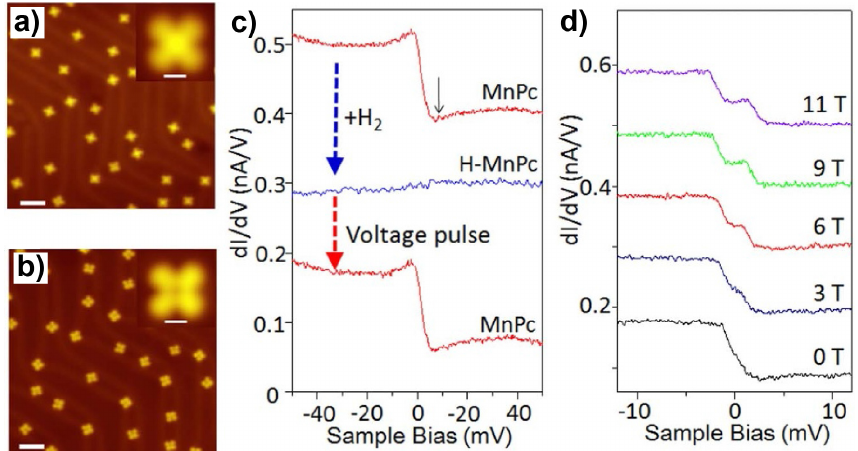
Figure 6. STM images of ( a ) MnPc and ( b ) H-MnPc on Au(111). ( c ) Sequential variations of d I / d V spectra recorded at the center of a MnPc molecule induced by the adsorption and desorption of a H atom. ( d ) Magnetic-field evolution of the Kondo feature of MnPc. Adapted from [64], with permission from Macmillan Publishers Limited, 2013